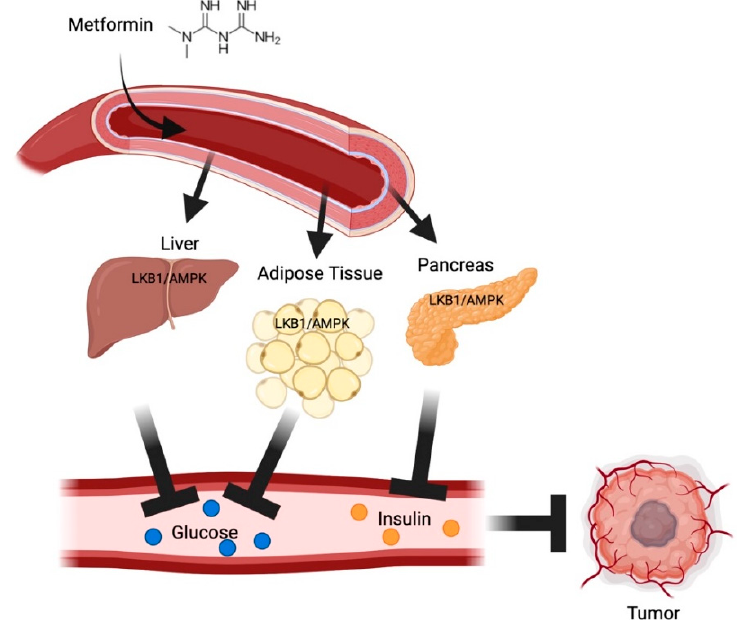
Figure 1. Overview of metformin’s systemic effects on tumor growth. Metformin’s activation of the LKB1/AMPK pathway in hepatocytes and adipocytes, and in the pancreas, leads to reduced blood glucose and insulin availability, respectively. Decreased glucose and insulin availability can slow tumor growth and progression. LKB1: Liver Kinase B1, AMPK: AMP-Activated Protein Kinase. Created in BioRender.